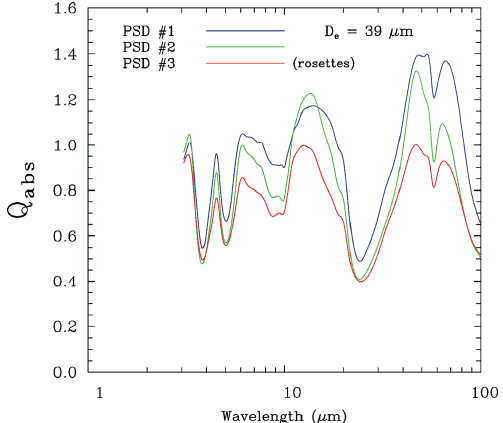
Figure 6. Wavelength dependence of Q abs for the 3 PSD described in Fig. 4, using the same color convention. All PSD have the same D e and IWC.